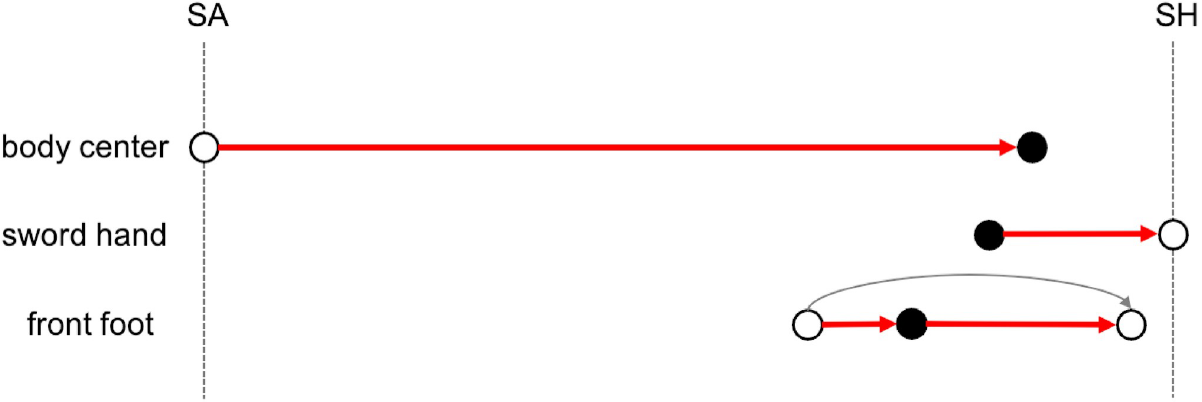
Fig 21. Motion scheme of Steffen’s lunge attack. The body center arrow describes the acceleration phase. The sword hand arrow describes the thrust to the touche´. The front foot arrow describes the propulsion of one step forward. Maximum velocity peaks are indicated by black dots.